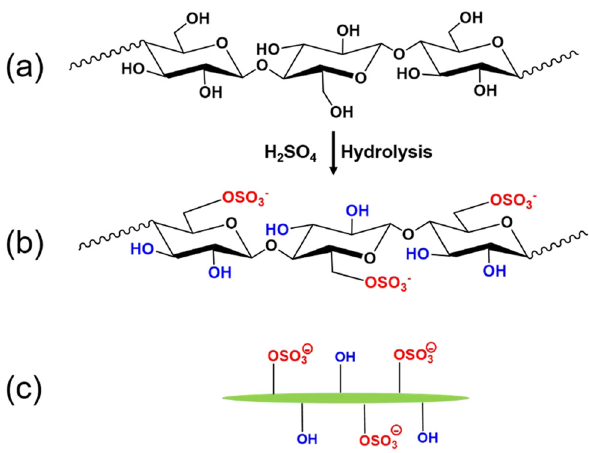
Figure 2: ( a ) Chemical structure of unmodi fi ed cellulose; ( b ) che - mical structure of sulfated cellulose; ( c ) scheme of rod - shaped sulfated cellulose nanocrystals with hydroxyl and negatively charged sulfate groups on the surface.